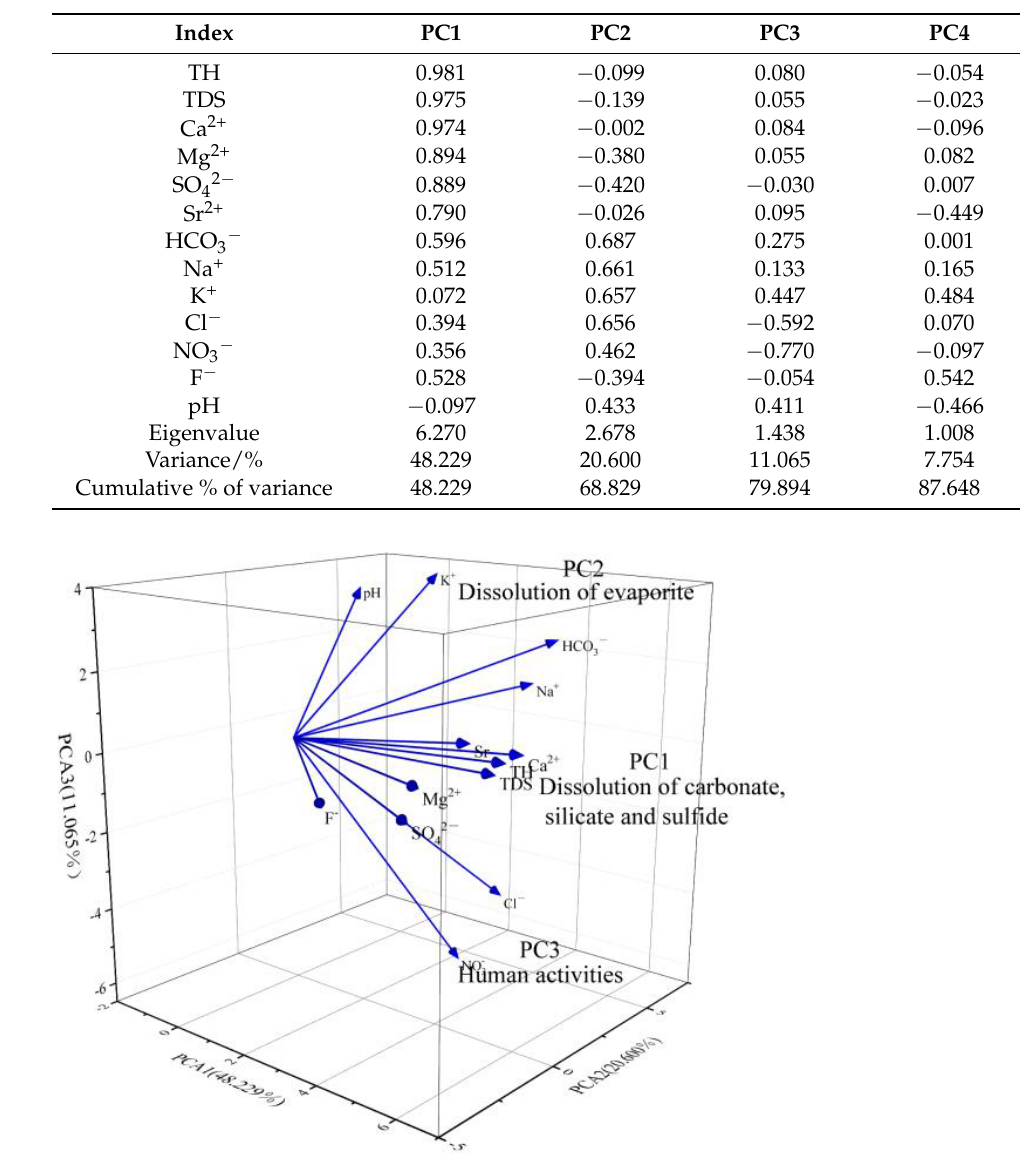
Table 3. Results of principal component analysis for each indicator of surface water and groundwater in the lower reaches of Yarlung Zangbo River.